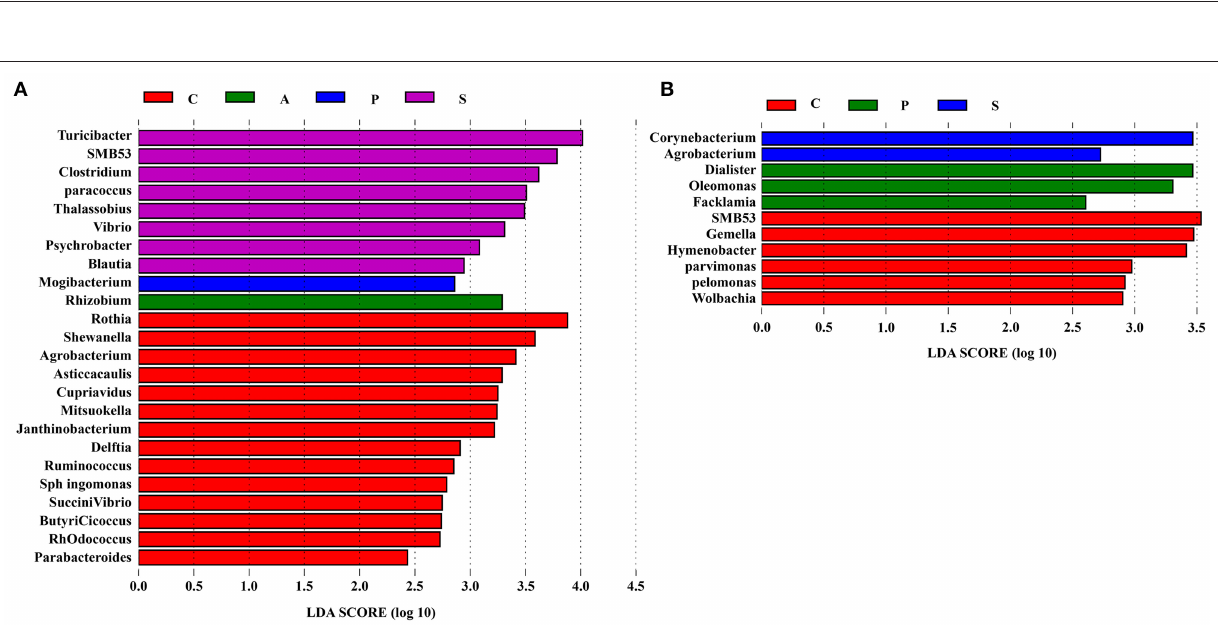
and these two additives exhibited similar effects.